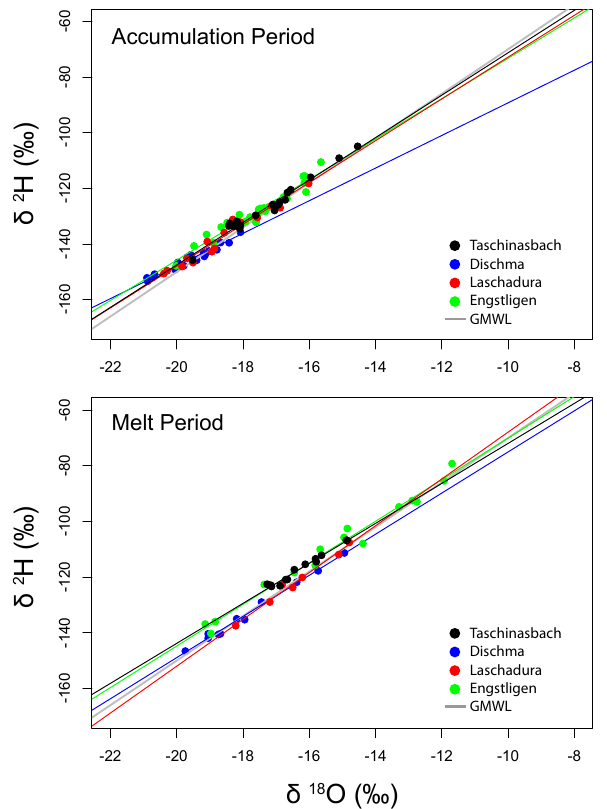
Fig. 3. 2 H- 18 O plot of the four different catchments, including their local meteoric waterline (LMWL) for the accumulation (top panel) and melt (bottom panel)